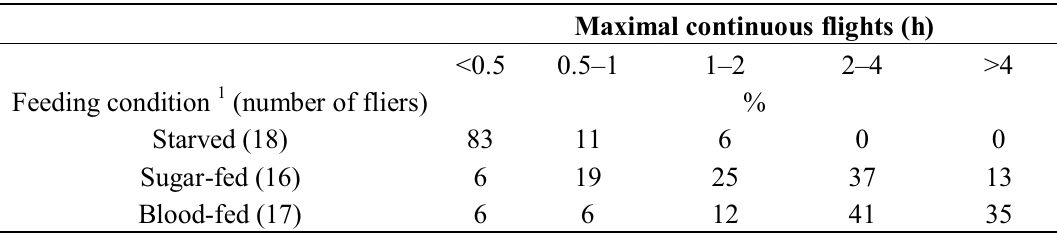
Table 1. Percentage of maximal continuous flight segments for female Ae. albopictus (day 3 post eclosion) in different nutritional states.